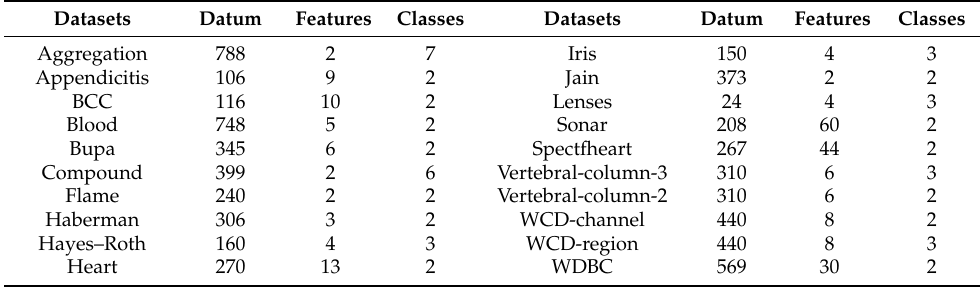
Table 2. Datasets’